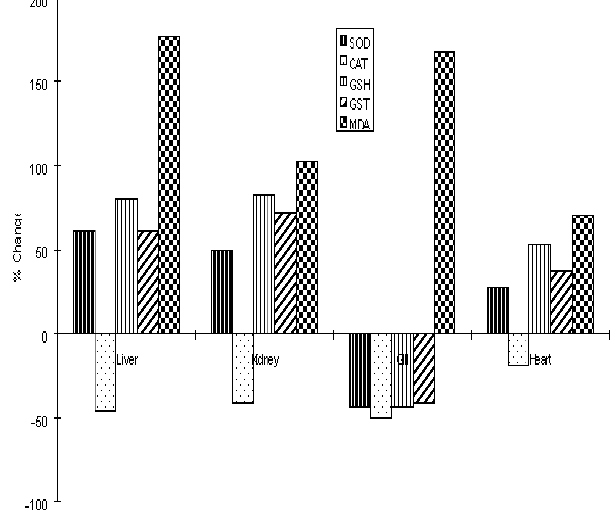
Figure 6: The percentage change in the activities of superoxide dismutase (SOD), catalase (CAT), glutathione S-transferase (GST) and the levels of glutathione (GSH) and malondialdehyde (MDA) in the livers, kidney, Gills and heart of Clarias gariepinus from the Ogun River relative to Agodi